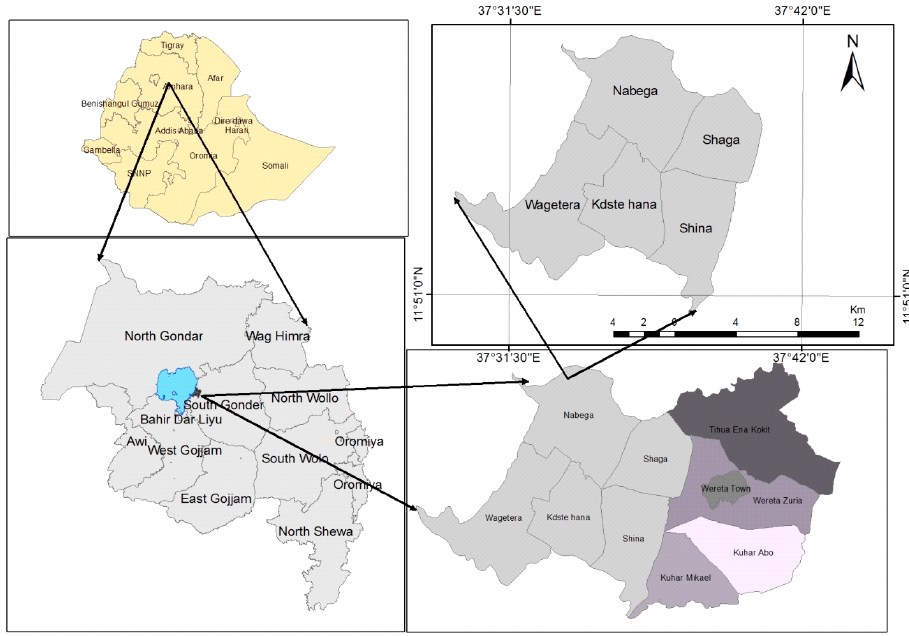
Figure 1. Map of the study area. Note: On the top left side of the map, Ethiopia with a geographical map of the Amhara region; on the bottom left side, the Amhara Region and regional zones; on the right bottom, Fogera Woreda with 10 biosphere reserve ‘Kebeles’; and on the top right side, the study site. Kebele—lowest administrative boundary under Woreda.